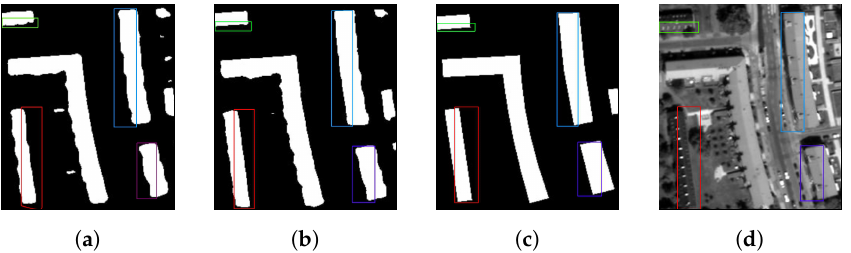
Figure 12. Detailed comparison of results produced by Hybrid-PS-FCN4sand Hybrid-PS-Unet models. ( a ) demonstrates the results obtained from Hybrid-PS-FCN4smodel, ( b ) depicts the resulted mask generated by Hybrid-PS-Unet and ( c ) shows a ground truth. ( d ) illustrates the real building representation in satellite